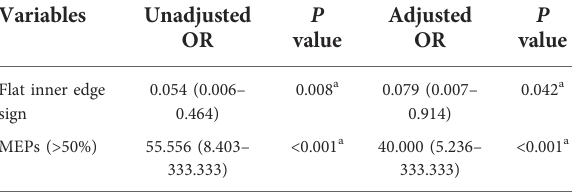
TABLE 4 Multivariate logistic regression analyses for estimating risk factors for paralysis.